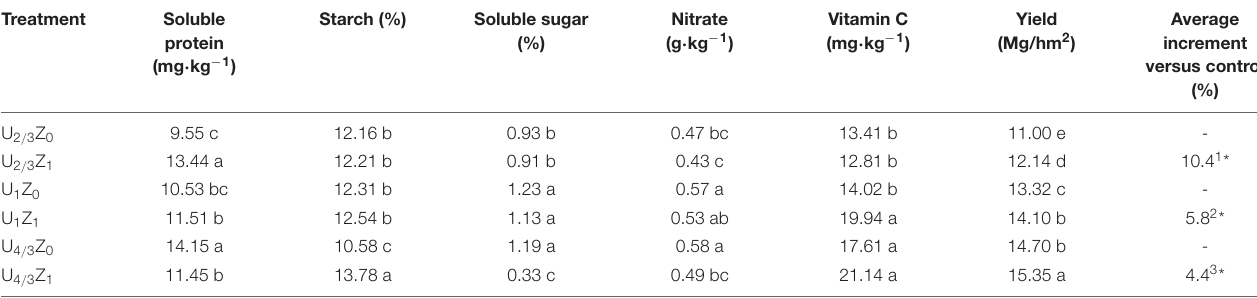
TABLE 4 | Quality and yield of fresh potato with different treatments. Treatment Soluble